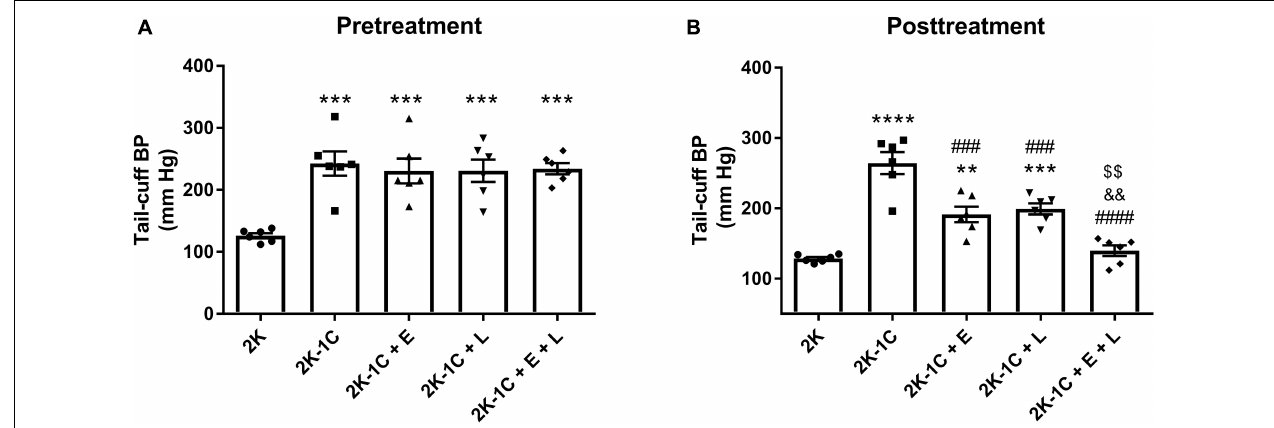
FIGURE 1 | Dual RAS blockade, but not losartan or enalapril alone, normalizes blood pressure in renovascular hypertensive rats. Blood pressure was measured using tail-cuff plethysmography in two-kidney one-clip (2K-1C) renovascular-hypertensive rats and controls (2K). Experiments were conducted (A) before and